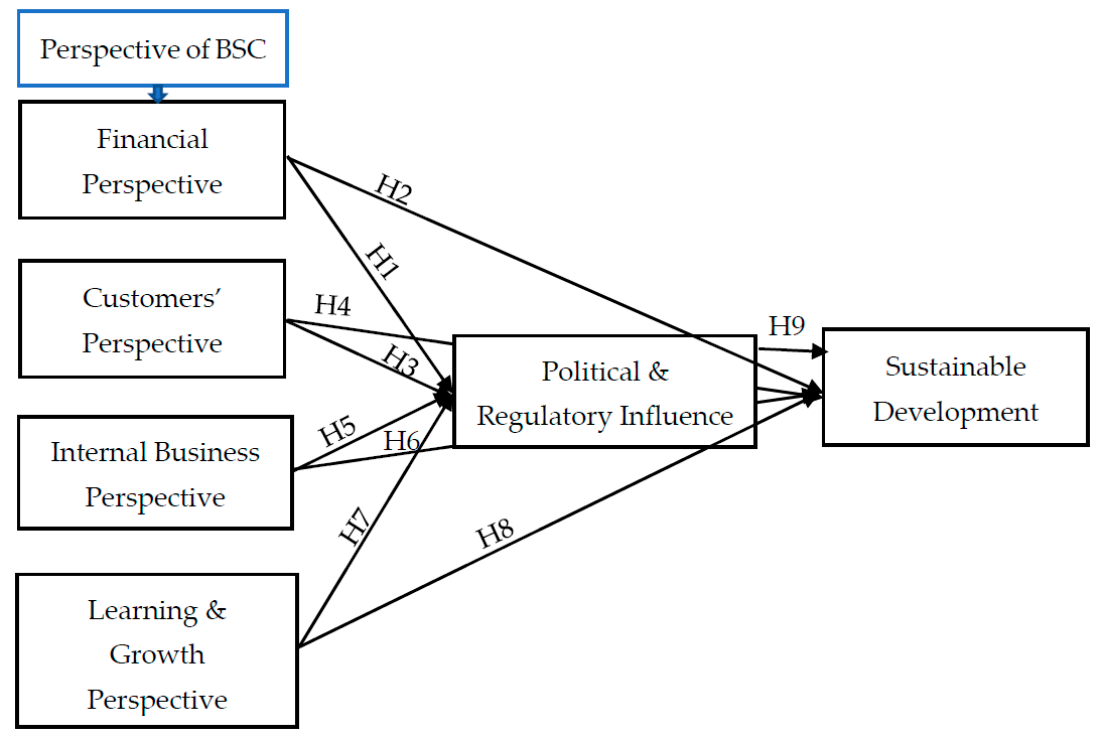
Figure 1. Research model with the hypothesis.